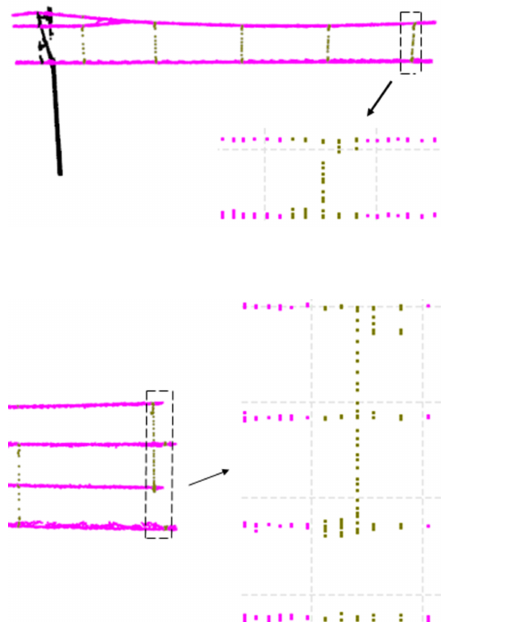
Figure 10. The overall accuracy of single frame classification model curves.